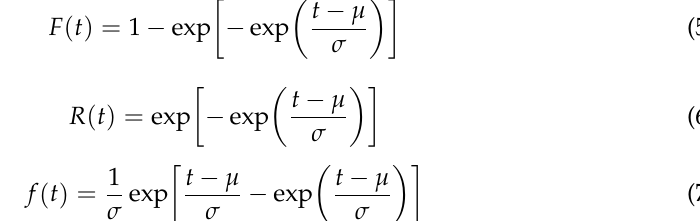
Figure 4. Accelerated life of MOCRC specimens with di ff erent thickness of protective layer.